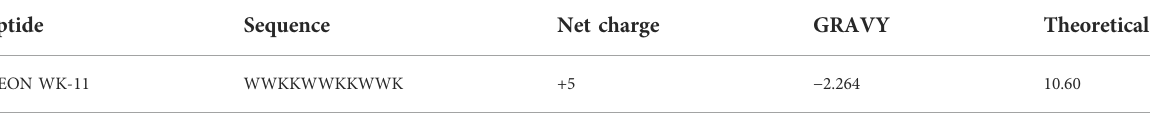
TABLE 1Primarystructure, net charge atneutralpH, grand average of hydropathicity(GRAVY)and theoretical isoelectric point(pI)of KDEONWK-11. Peptide